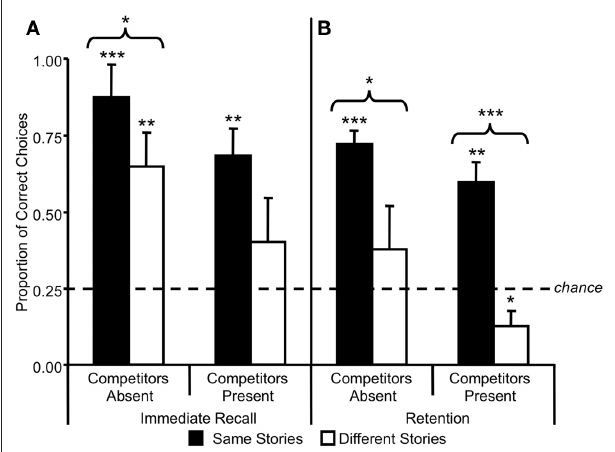
Figure 6 | results from the recall (A) and retention trials (B) as a function of whether the direct competitor was present. The y -axis represents proportion of correct choices on the four-alternative test trials. The dotted line represents chance (0.25). Error bars represent one standard error of the mean. * p < 0.05, ** p < 0.01, *** p <